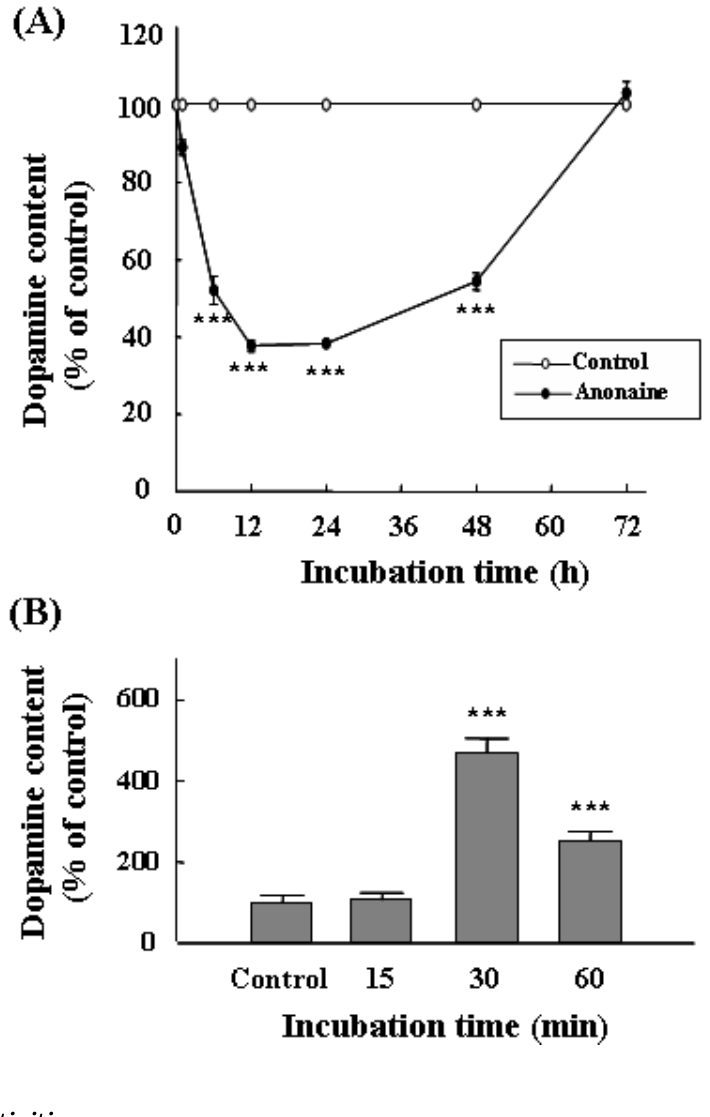
Figure 2 . Time courses of intracellular (A) and extracellular (B) dopamine content by anonaine (0.05 µM) in PC12 cells. The intracellular and extracellular dopamine content of control levels were 3.78 ± 0.26 and 0.15 ± 0.05 nmol/mg protein, respectively. Results represent means ± S.E.M. of 6-8 dishes. Significantly different from control values: ***P<0.001 (ANOVA followed by Tukey’s